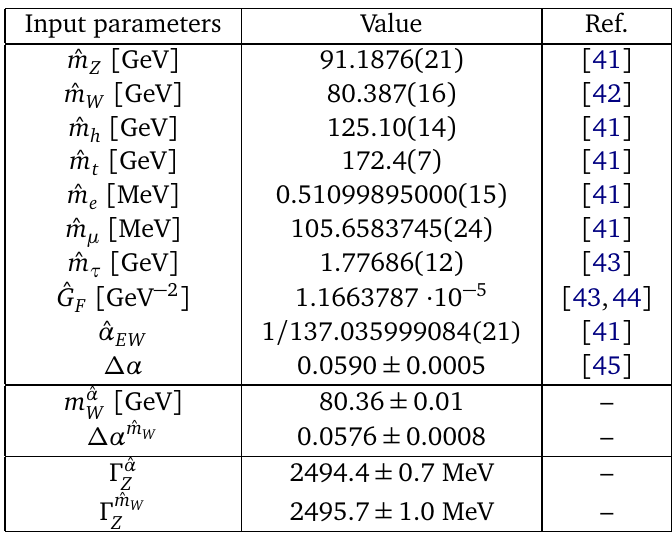
Table 1: Input parameter values used in this work, the last two lines are m predicted in the α scheme and ∆ α as predicted in the m for the SM using the values given above. Table taken from [ 20 ] , where further details can be found. Note that the fermion mass is always used as the input